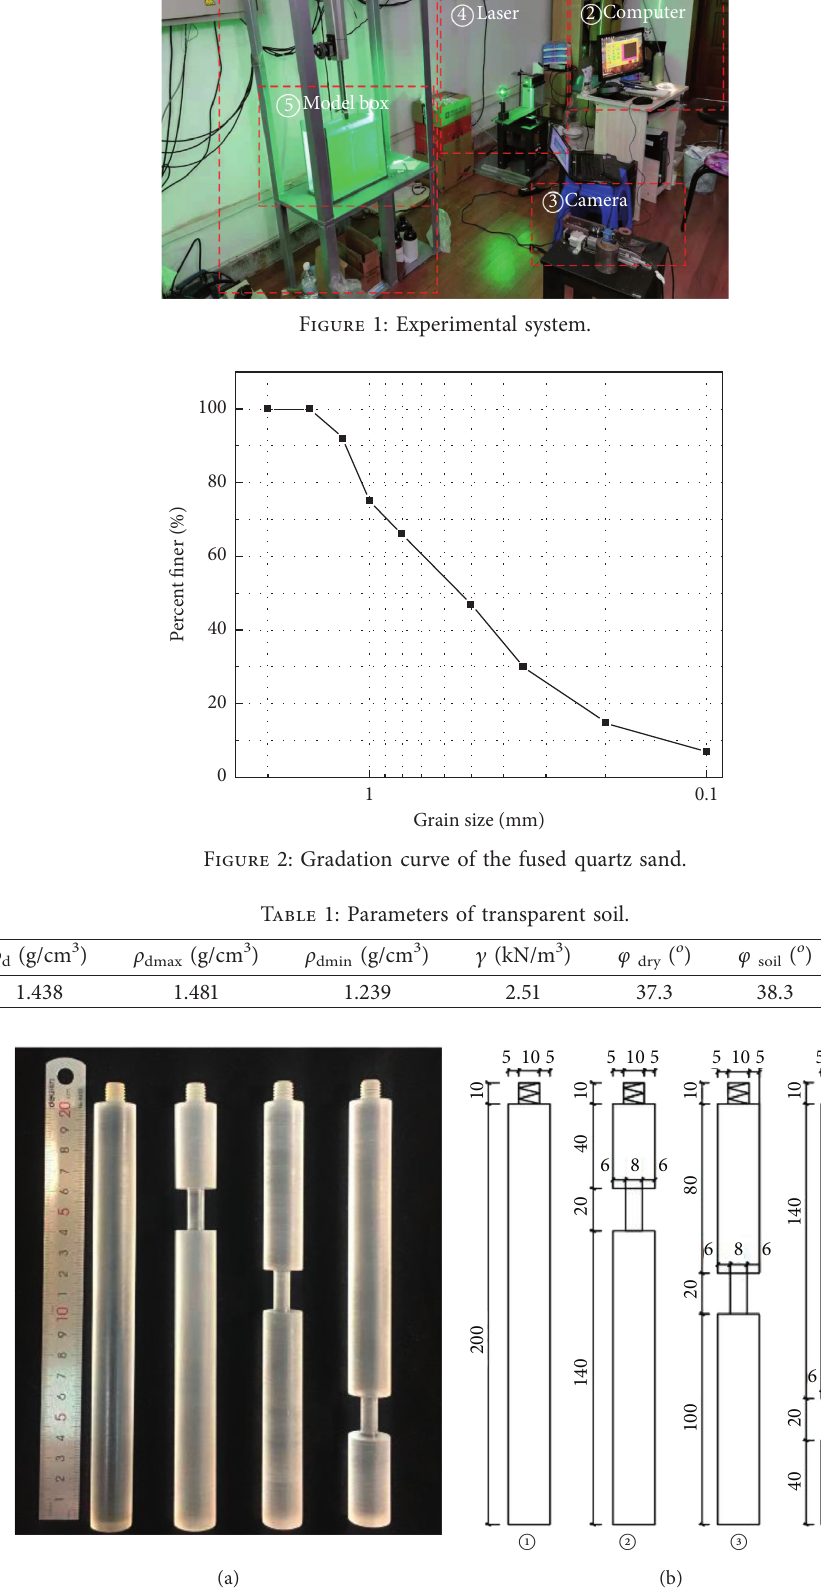
Figure 3: Physical and dimensions of model piles. (a) Physical model piles. (b) Dimensions of model piles.